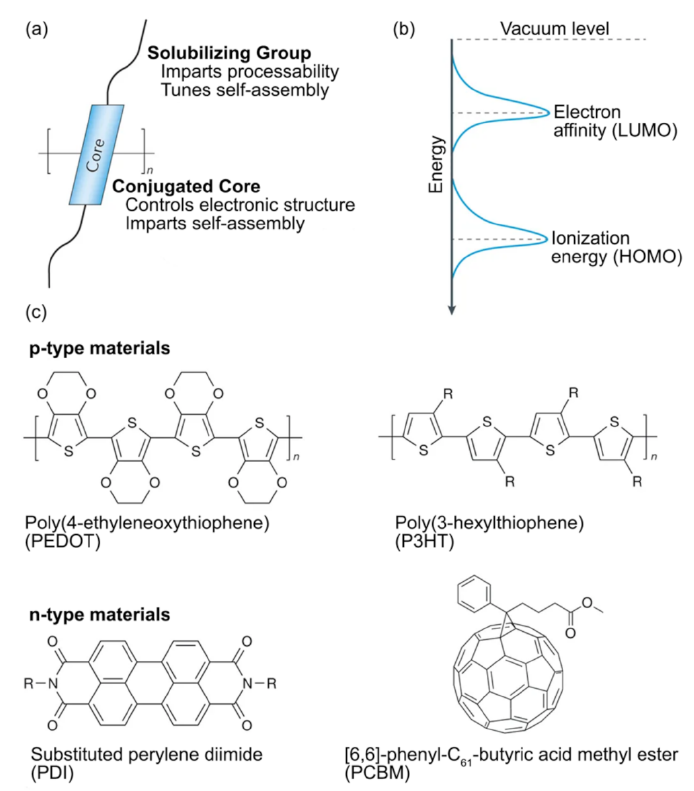
Figure 5. Organic TE materials and their structures. ( a ) Polymeric semiconductors have π -conjugated cores that enable charge transport and side chains that can impart solution processability, charge carrier creation, and molecular assembly. ( b ) Ionization energy (HOMO) and electron affinity (LUMO) of polymeric semiconductors can be tuned via their molecular design. ( c ) Molecular structures of high-performance p and n-type OTEs. Adapted from Russ et al. [34] copyright 2016, The Authors. Most reported OTEs are intrinsically p-type because the electron affinity of